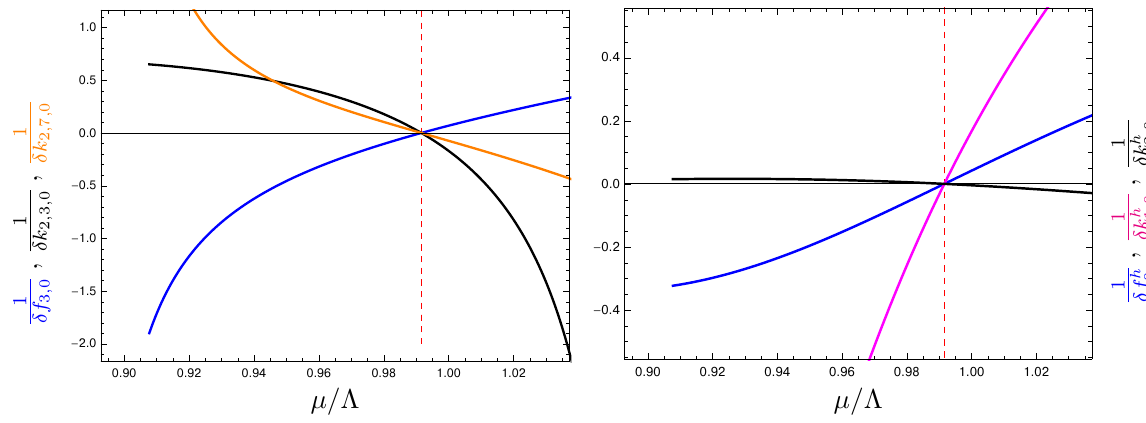
, δk h , δk h of the chiral symmetry breaking 0 1 , 0 2 , 0 } , evaluated at fixed explicit chiral symmetry breaking Λ